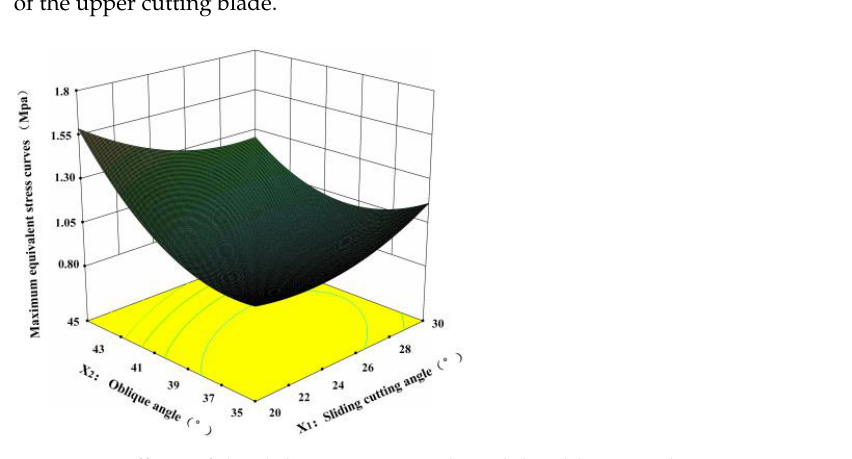
Figure 12. Effects of the sliding–cutting angle and the oblique angle on maximum equivalent stress of the bottom cutting blade.